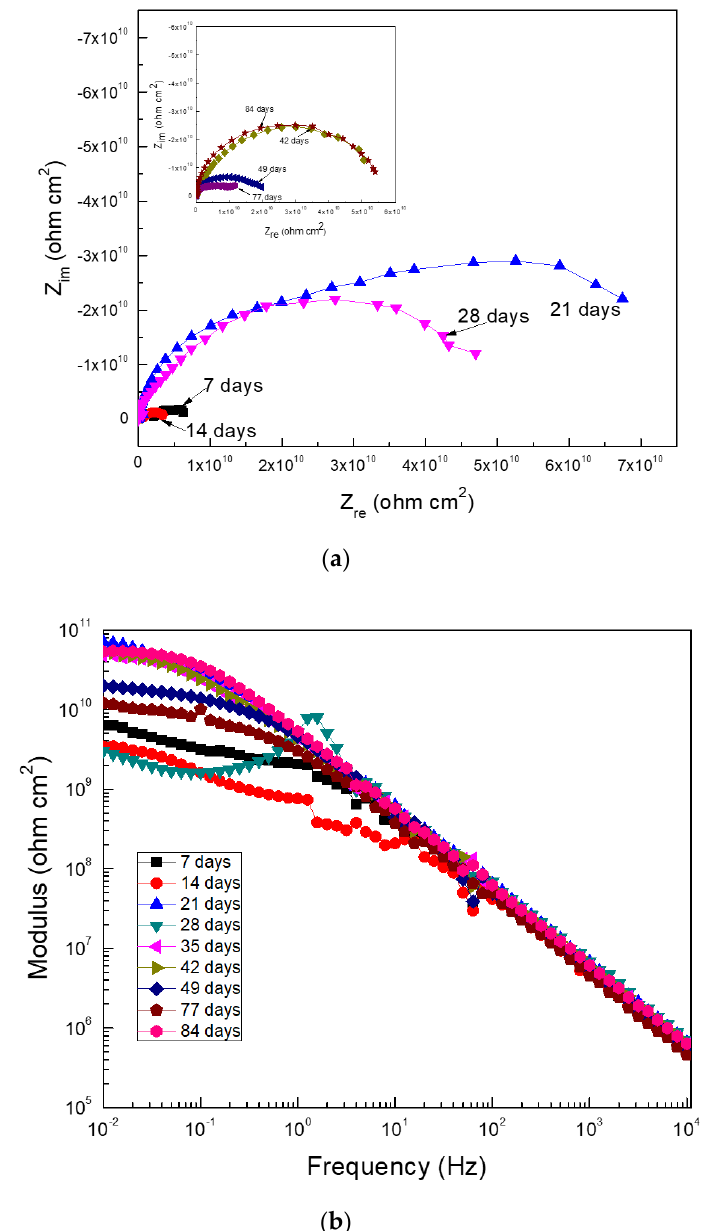
Figure 9. EIS data in the ( a ) Nyquist and ( b ) Bode formats for Al in the blend containing ethanol obtained from apples.